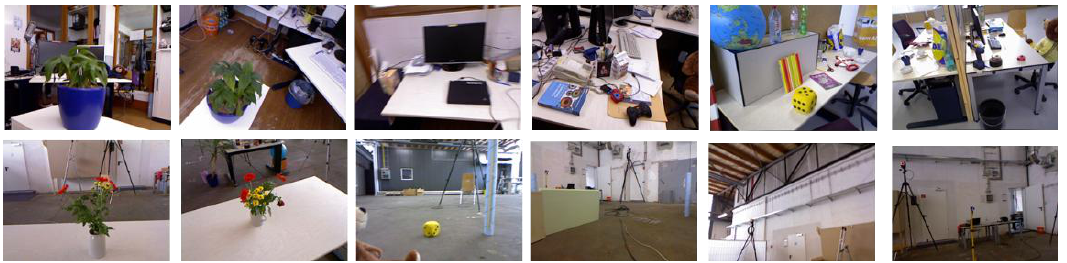
Figure 7. Images in living room scene of ICL-NUIM dataset.